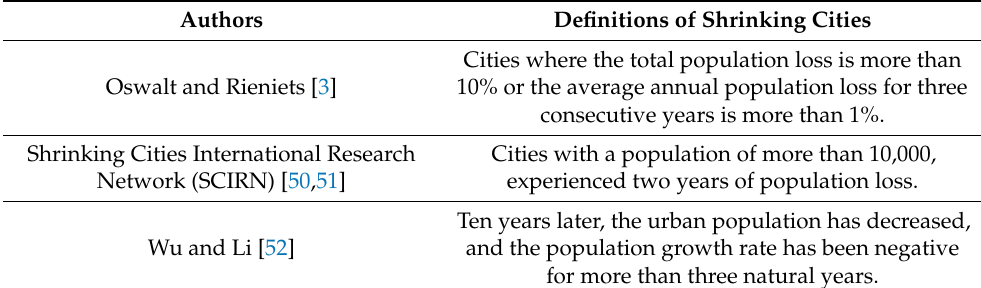
Table 2. Different definitions of shrinking cities put forward by scholars.